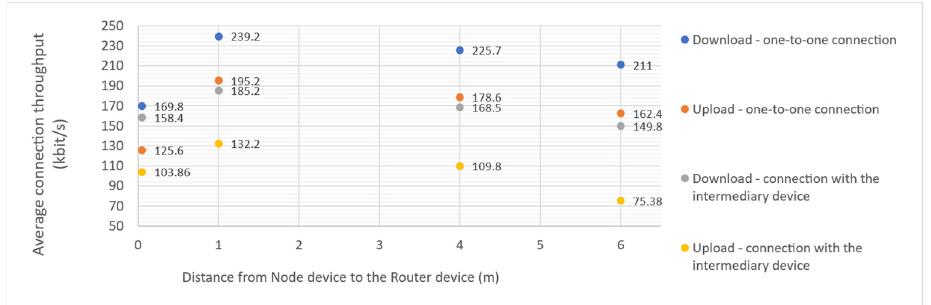
Figure 11. 6LowPAN BLE average connection throughput measured in the test network using iperf3 software. The measurement was performed 50 times in each configuration. The obtained results were similar and repetitive. The points presented on the chart correspond to the averages of those results.